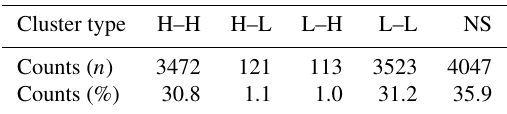
Table 3. Number and percentage of samples in each type of spatial